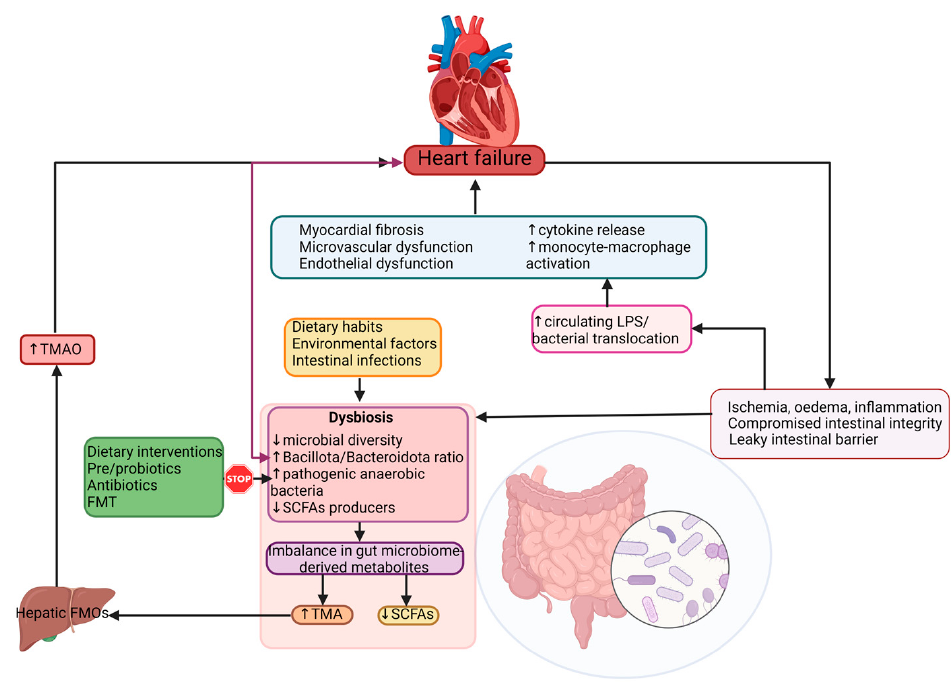
Figure 1. Concept of the gut–heart axis adapted to HF.